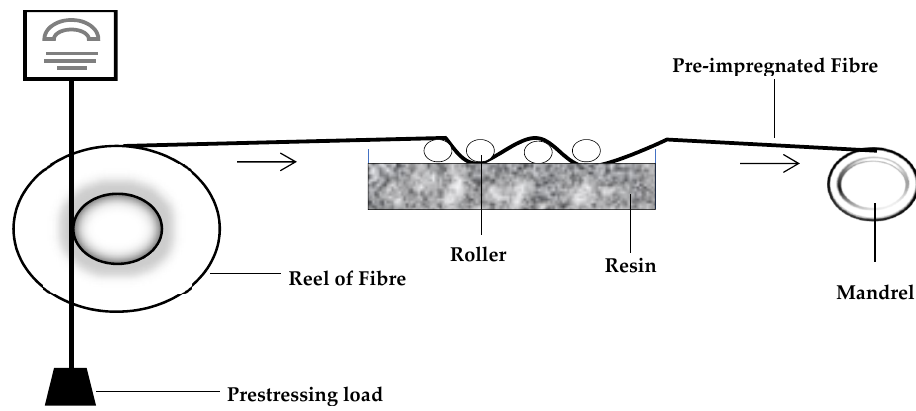
Figure 5. Schematic representation of the filament winding technique.